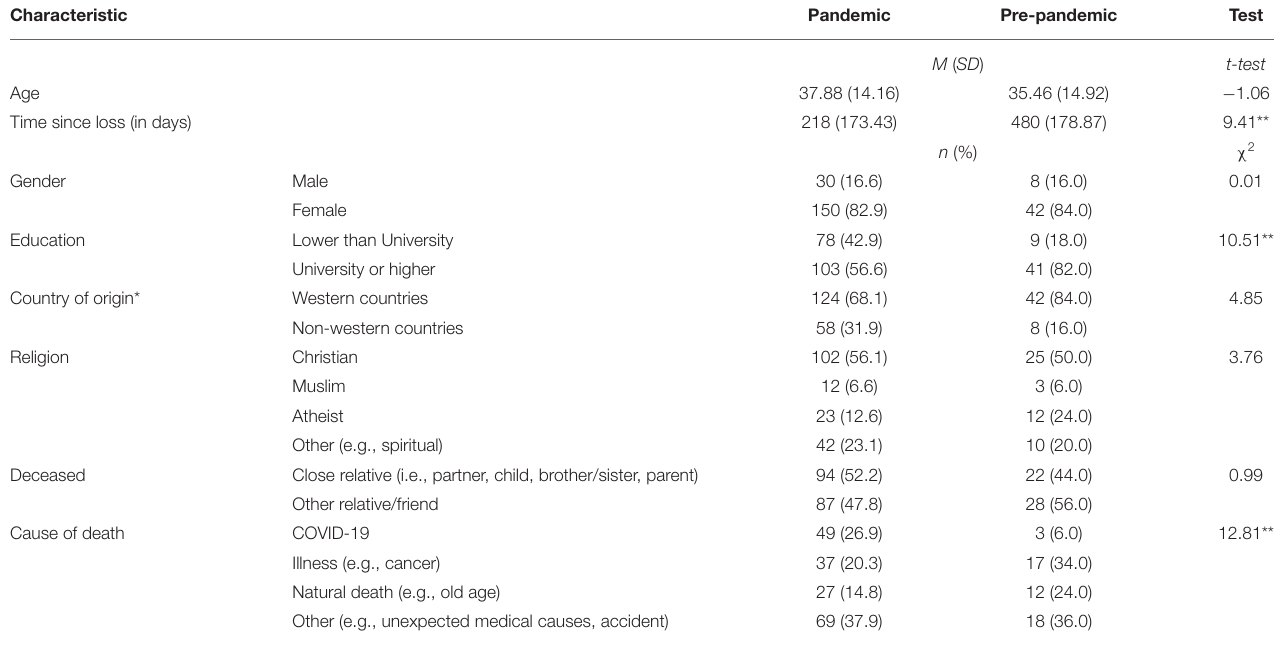
TABLE 1 | Demographics and loss-related characteristics of the sample and group differences ( n = 232).